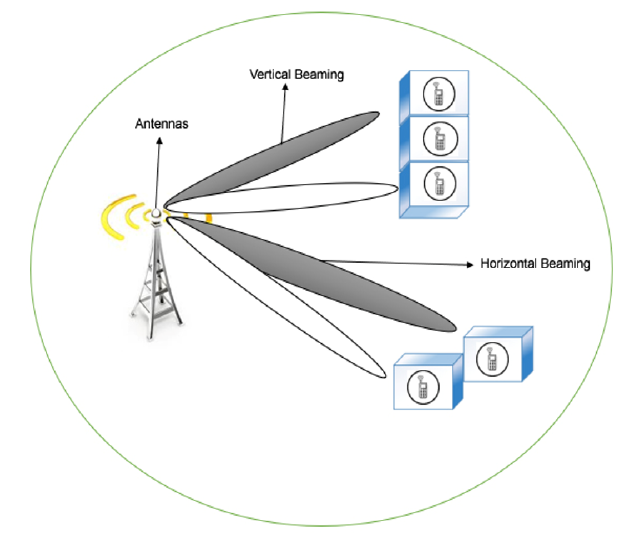
Figure 6. Massive MIMO and 3D